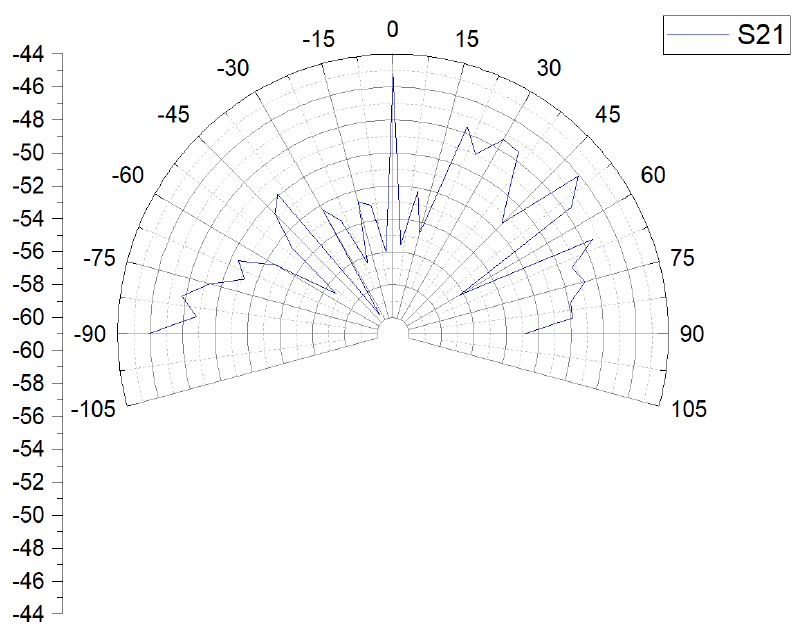
Figure 12. Gain measured